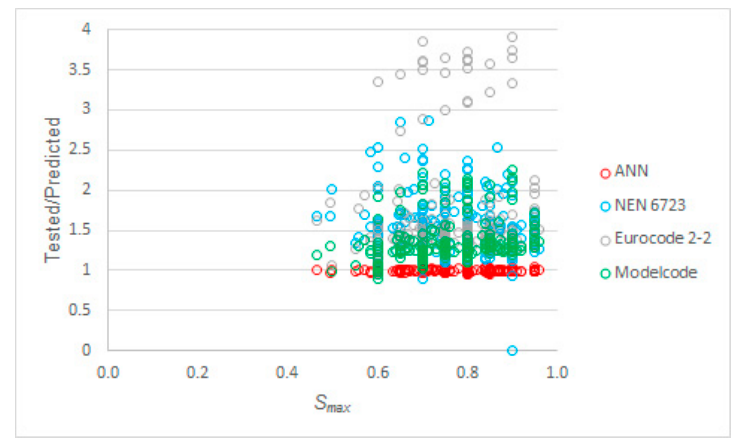
Figure 10. Tested to predicted values for all considered methods as a function of S max .